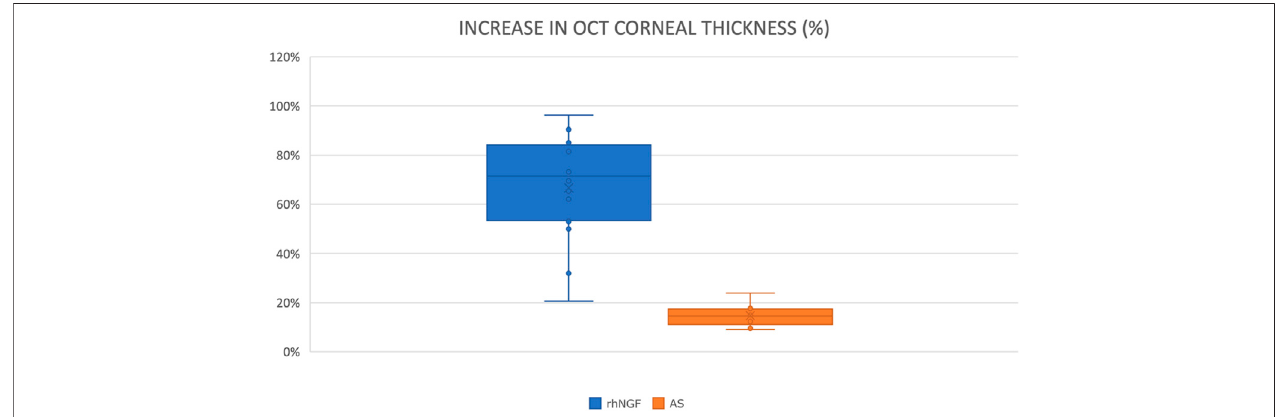
GRAPH 2 | Box plot representing the difference of percentage AS-OCT increase in corneal thickness between the cenegermin (rh-NGF) group and the AS group.